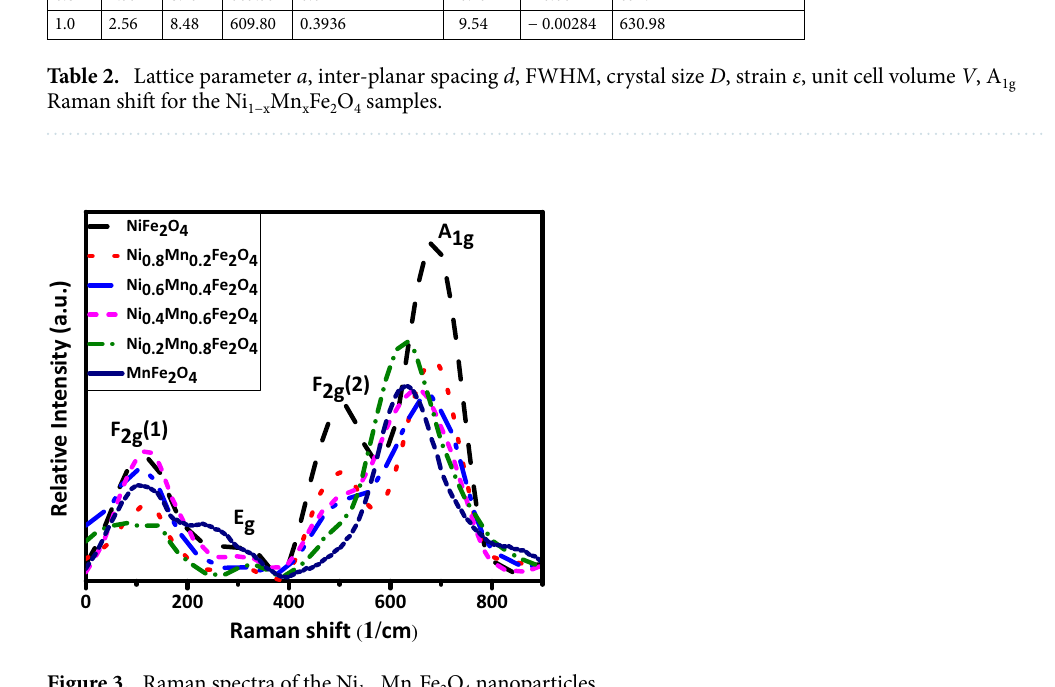
from the Y-intercept and the slope of the line from the plot of 4Sinθ versus βCosθ 40 , respectively, as reported in Table 2. The lattice parameter a , also reported in Table 2, was calculated using Eq. (2) for the most intense peak 41 :